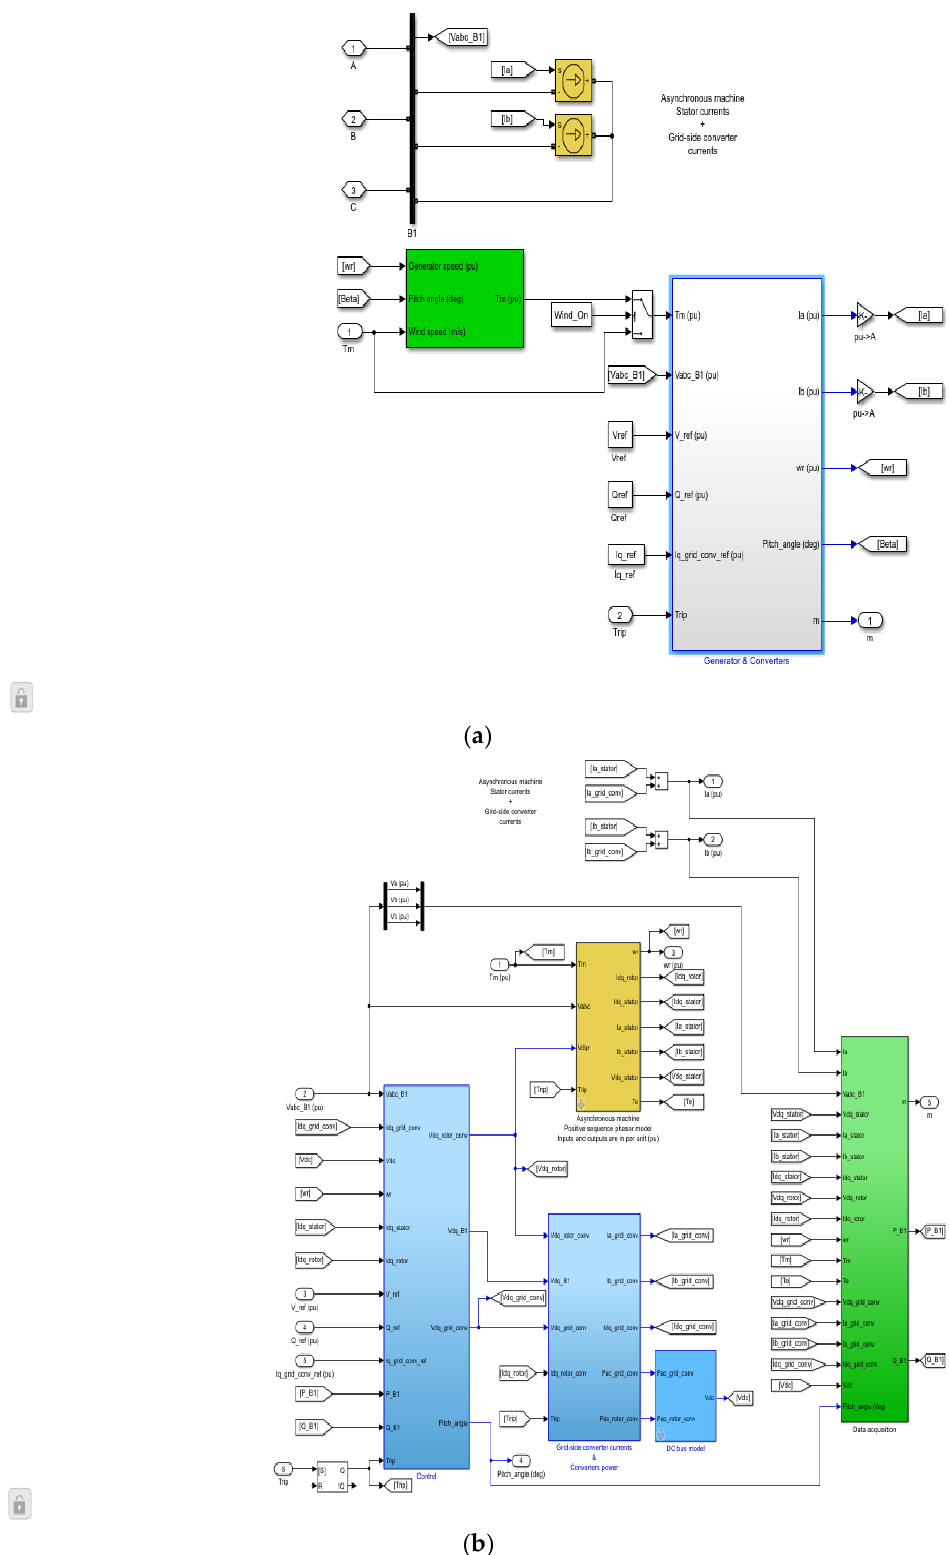
Figure 7. Detail model for DFIG generator, wind turbine, and converter under the mask. ( a ) DFIG generator and converter subsystem under the mask. ( b ) The inner loop for the generator and converters subsystem.